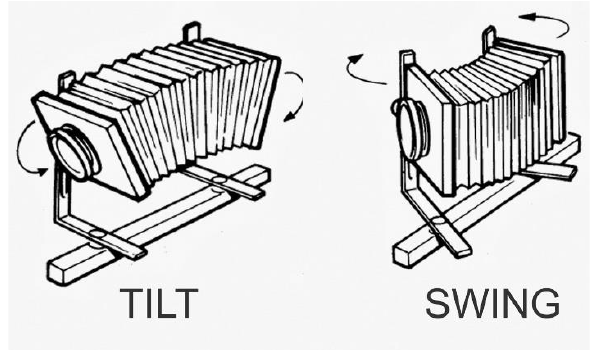
Figure 3: Rotation of front and rear standards around a horizontal axe (tilt) and a vertical axe (swing).